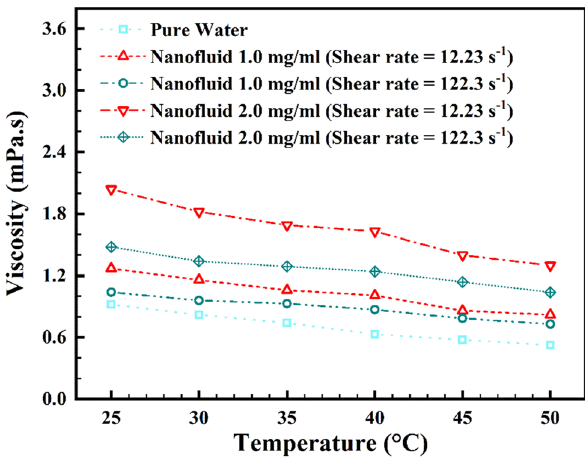
Figure 12: Change in rheological behavior corresponding to tem - perature at varied mass concentrations.